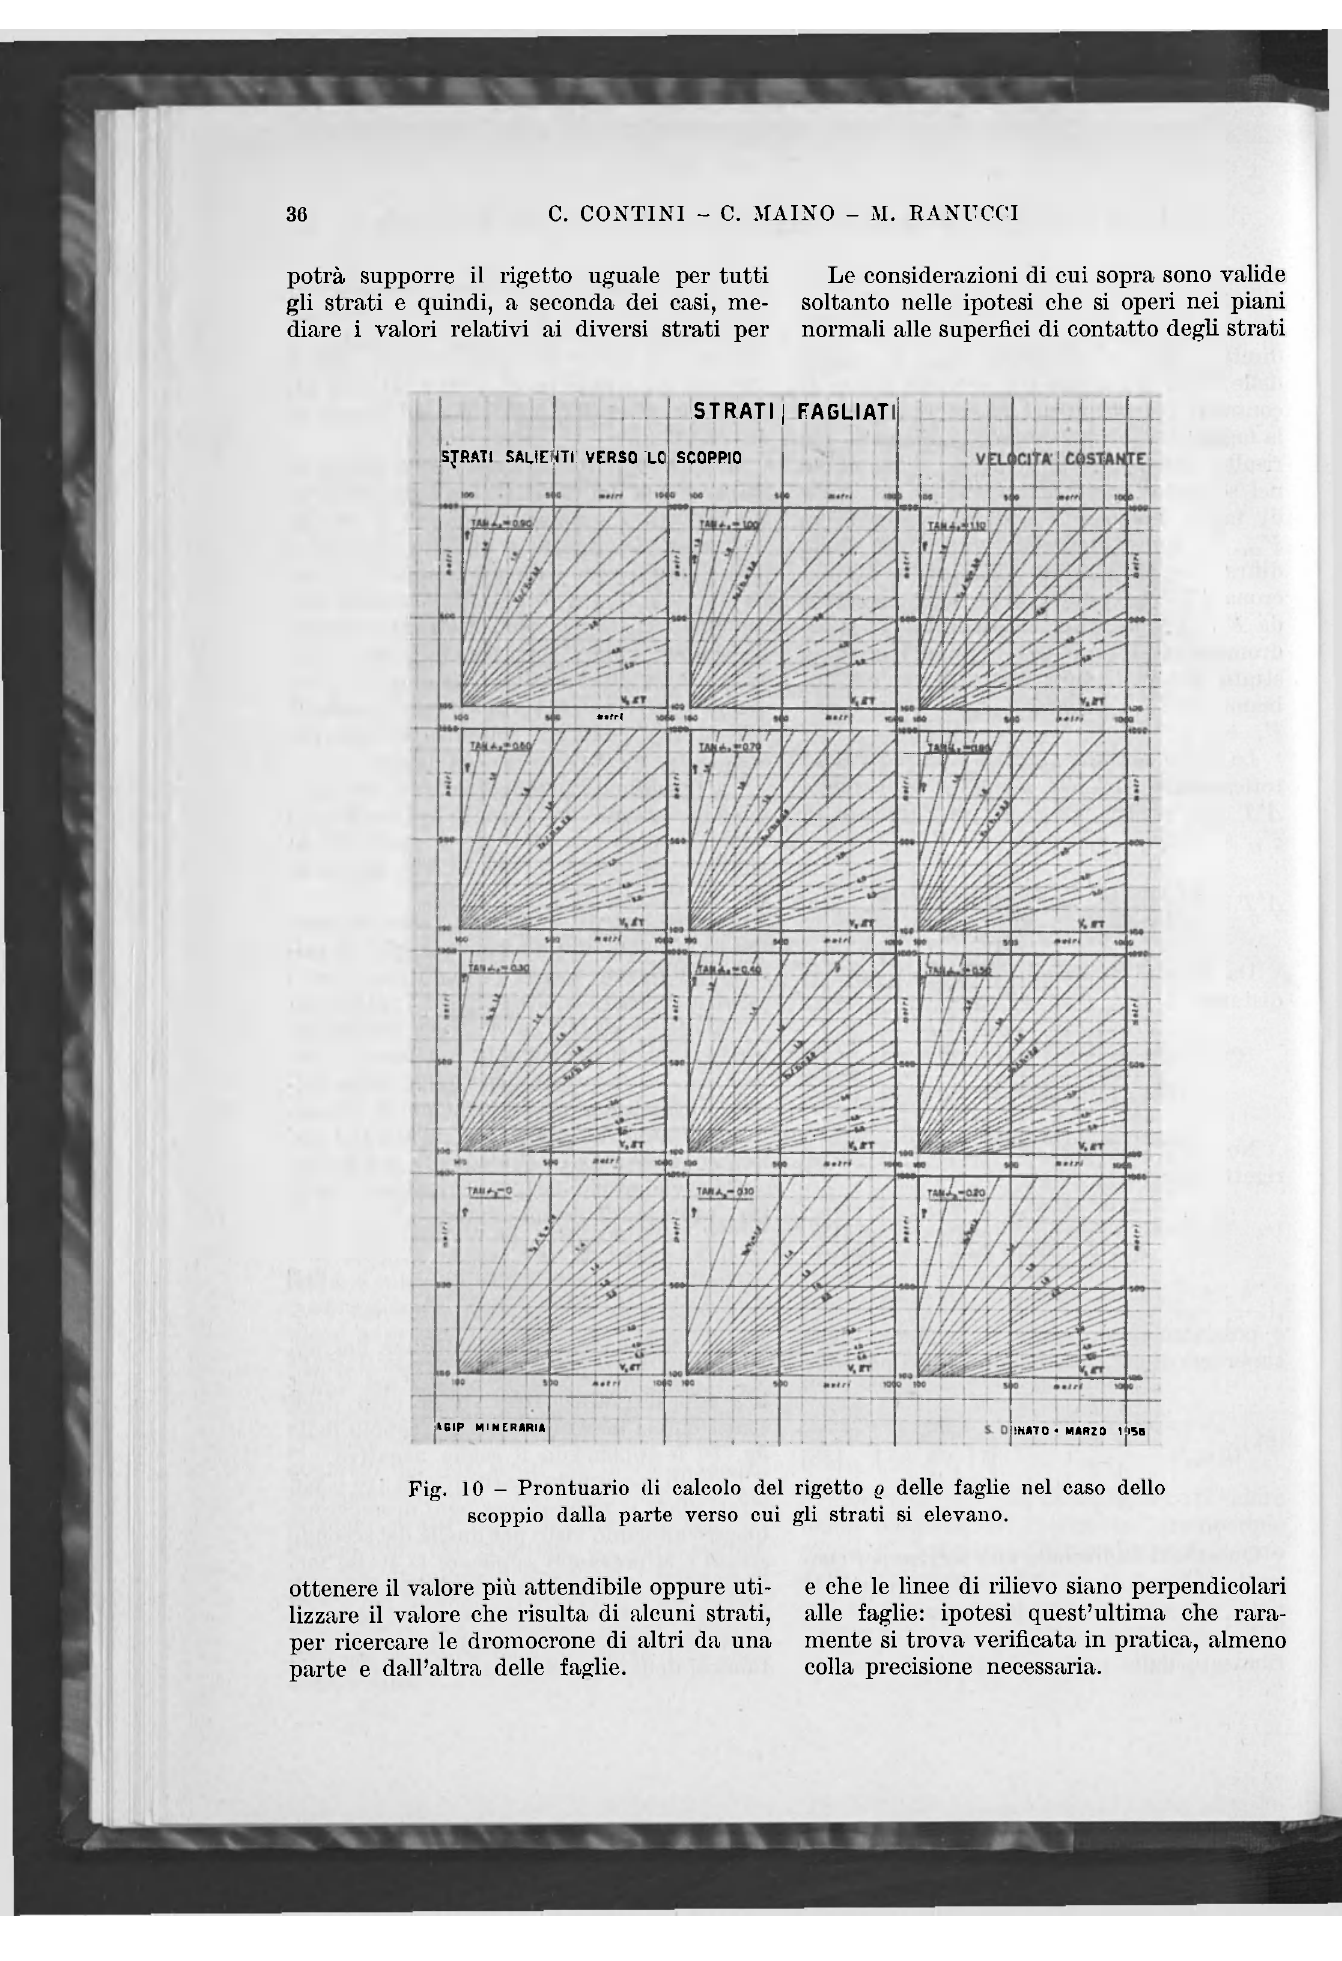
Fig. 10 - Prontuario (li calcolo del rigetto Q delle faglie nel caso dello scoppio dalla parte verso cui gli strati si